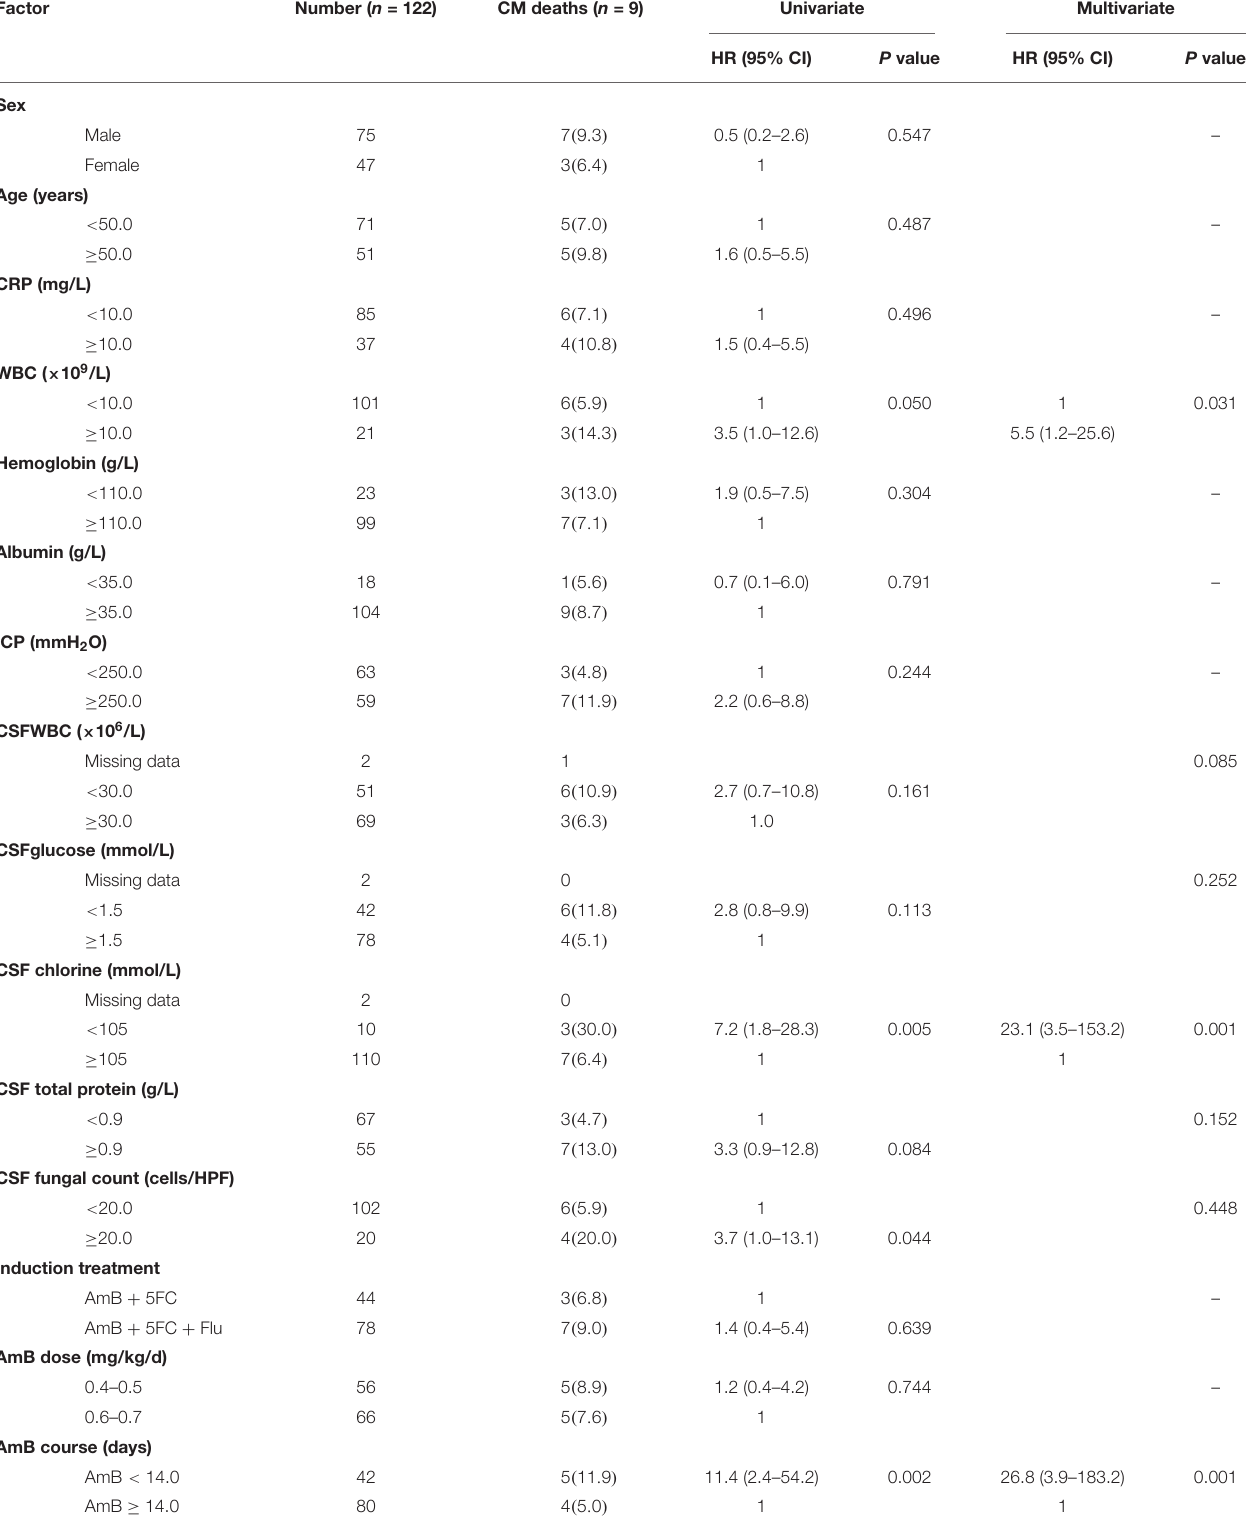
TABLE 2 | Risk factors for 10-week mortality in CM patients in univariate/multivariate Cox proportional hazards models.